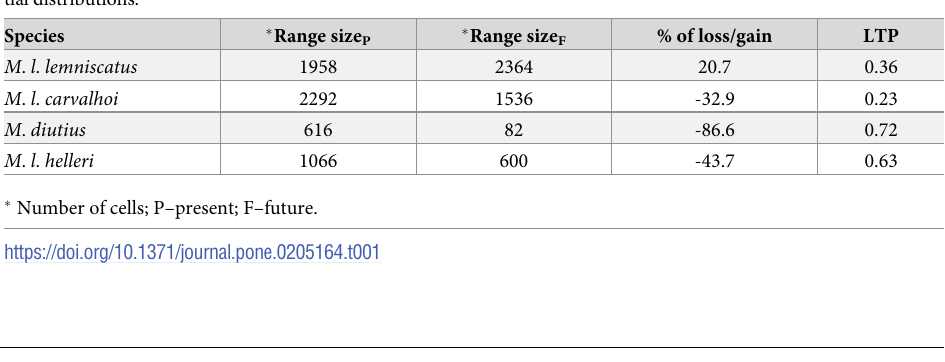
Table 1. Changes in geographic distribution measured as the difference in the number of 0.5 × 0.5˚ cells in which species are predicted to occur in the present and in the future. LPT: Lowest presence threshold used to cut the poten- tial